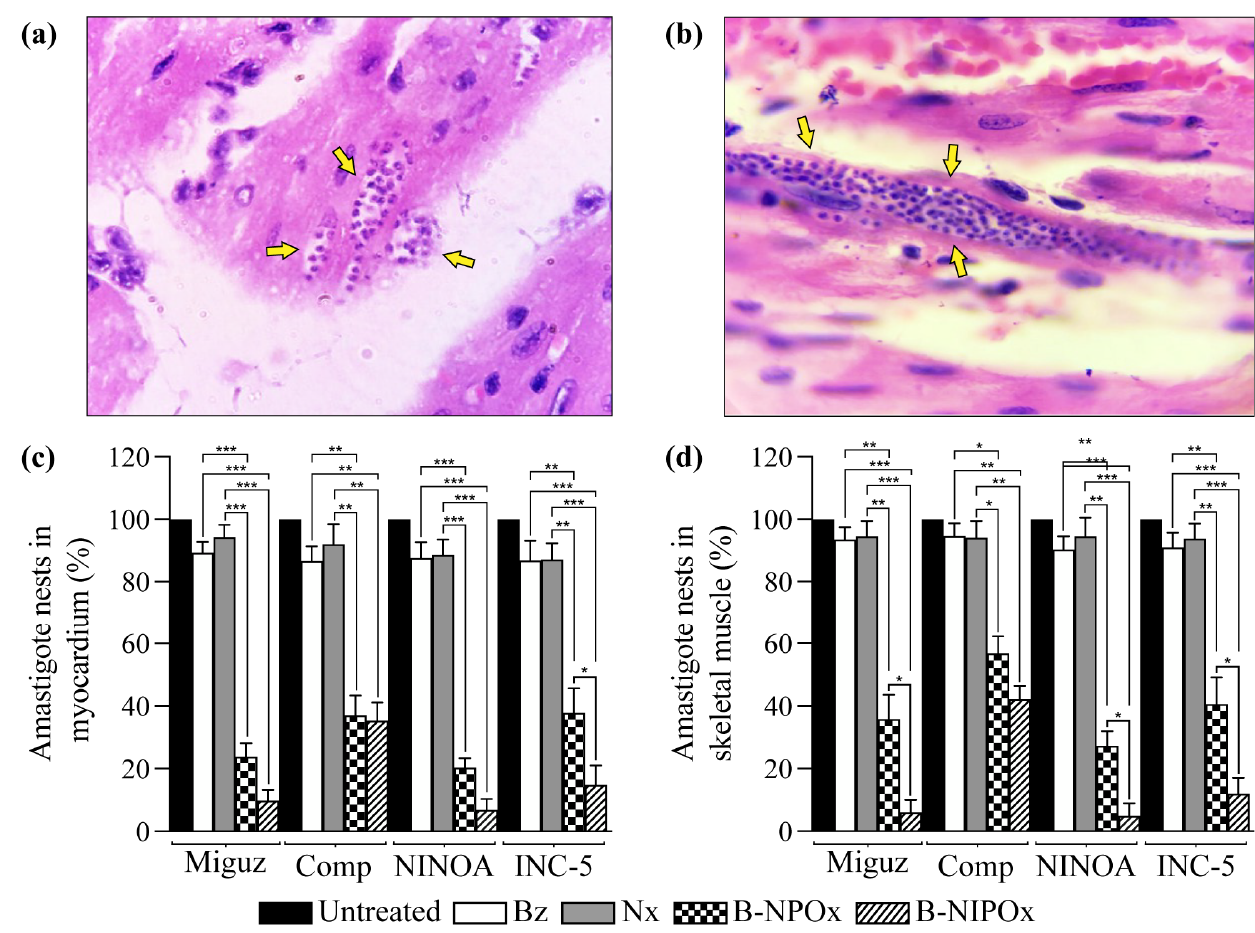
Figure 6. The benzyl ester of N-isopropyl oxamic acid (B-NIPOx) is more effective to reduce the percentage of amastigote nests in the myocardium and in the skeletal muscle of mice infected with Trypanosoma cruzi than the benzyl ester of N-propyl oxamic acid (B-NPOx) and the reference drugs Benznidazole and Nifurtimox. Representative photographs (40 × ) of ( a ) the myocardium and ( b ) the skeletal muscle of CD-1 mice infected with the INC-5 T. cruzi strain. The yellow arrows indicate the amastigote nests in the myocardium and the skeletal muscle. The amastigote nests of untreated or treated CD-1 mice, which were infected with the Miguz, Compostela (Comp), NINOA or INC-5 T. cruzi strains, were counted in myocardium and skeletal muscle slides stained with H/E. The infected mice were treated with Benznidazole (Bz), Nifurtimox (Nx), B-NPOx or B-NIPOx, with daily dosing at 100 mg/Kg for 50 days. The mean number of amastigote nests in the infected and untreated group was set as 100%. Asterisks represent statistically significant differences between the (%) of amastigote nests in ( c ) the myocardium or ( d ) the skeletal muscle (* p ≤ 0.05, ** p ≤ 0.01 and *** p ≤ 0.001). n = 6. One experiment representative of three is